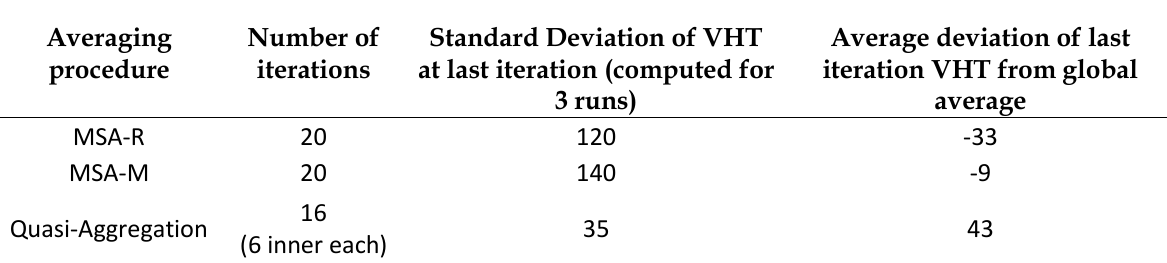
Convergence of averaging